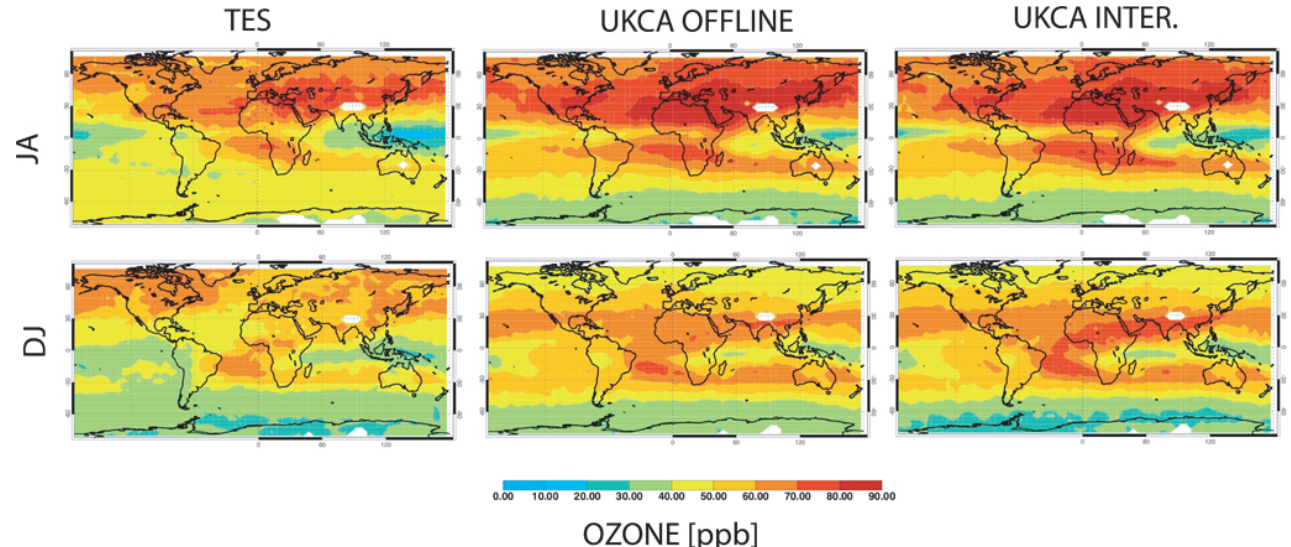
Fig. 4. Ozone [ppbv] averaged over 800–400hPa from 2005–2008 July/August (top row) and Dec/Jan (bottom row). Left column: observa- tions from TES. Middle column: model with offline photolysis. Right column: model with interactive